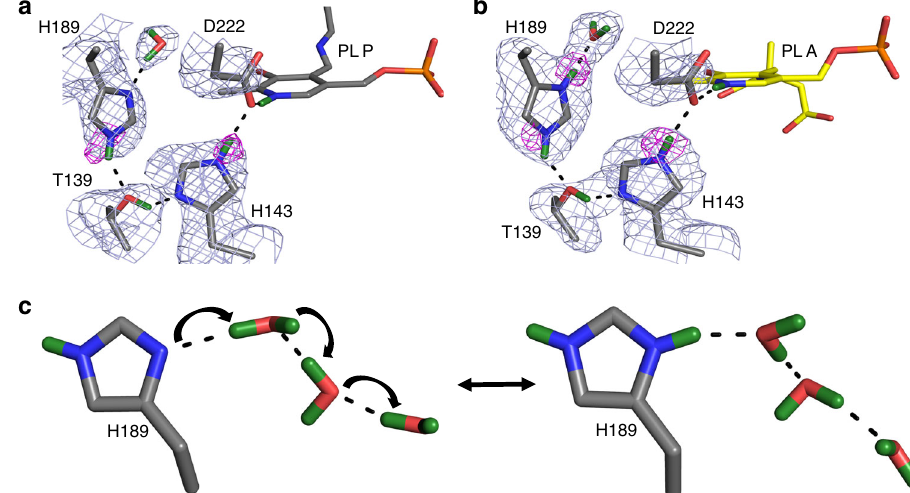
Fig. 5 Extended hydrogen bond network near N1-PLP in the internal aldimine a and external aldimine b . c Proposed Grotthüss proton hopping mechanism, leading to the protonation of H189 during the formation of the external aldimine. For clarity, the omit | F o | − | F c | difference nuclear scattering maps are presented for deuterium atoms on His